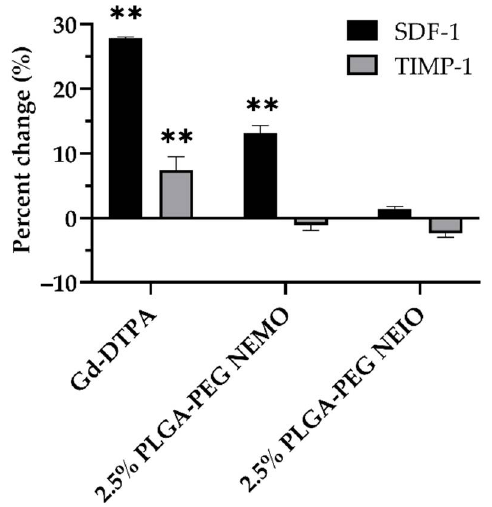
Figure 6. Gd-DTPA and NEMO particles alter neutrophil cytokine release. A Proteome Profiler Mouse Cytokine Array Kit, Panel A was utilized to investigate differences in neutrophil cytokine expression upon stimulation with different contrast agents. Changes in TIMP-1 and SDF-1 were expressed as percent change relative to unstimulated neutrophils. Gd-DTPA appeared to most significantly alter both SDF-1 and TIMP-1 production relative to unstimulated neutrophils. ** indicates significance ( p < 0.01). Error bars represent standard error.